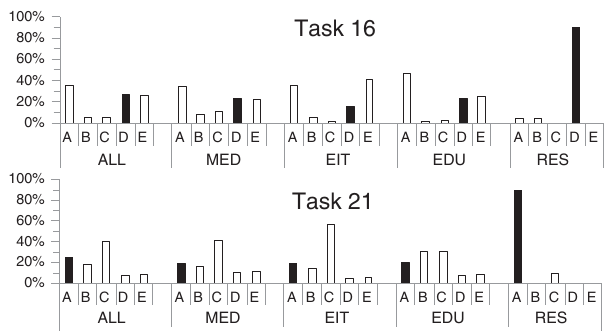
FIG. 6. The students ’ responses to the tasks grouped by the gas temperature concept concerned. For a detailed description see Fig.